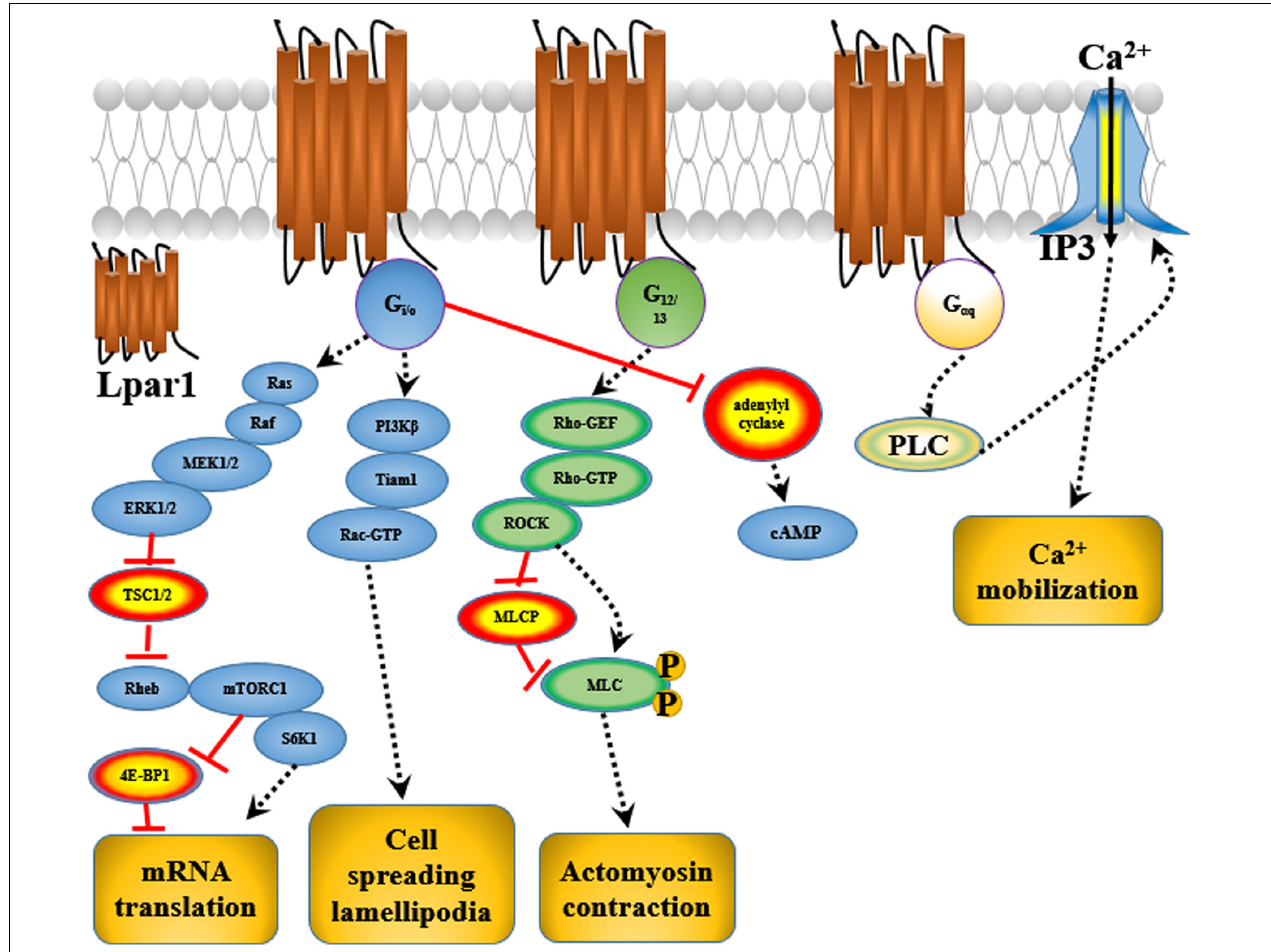
FIGURE 3 | The possible mechanisms by which Lpar1 exerts its effects in glial and neuronal